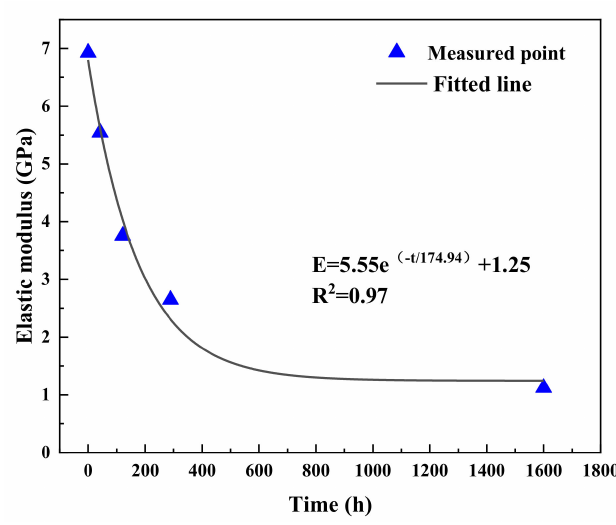
Figure 11. Fitting curve of relationship between elastic modulus and